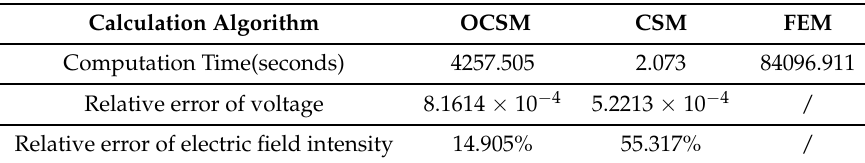
Table 4. Comparison of experiment results of optimized charge simulation method (OCSM), charge simulation method (CSM), and finite element method